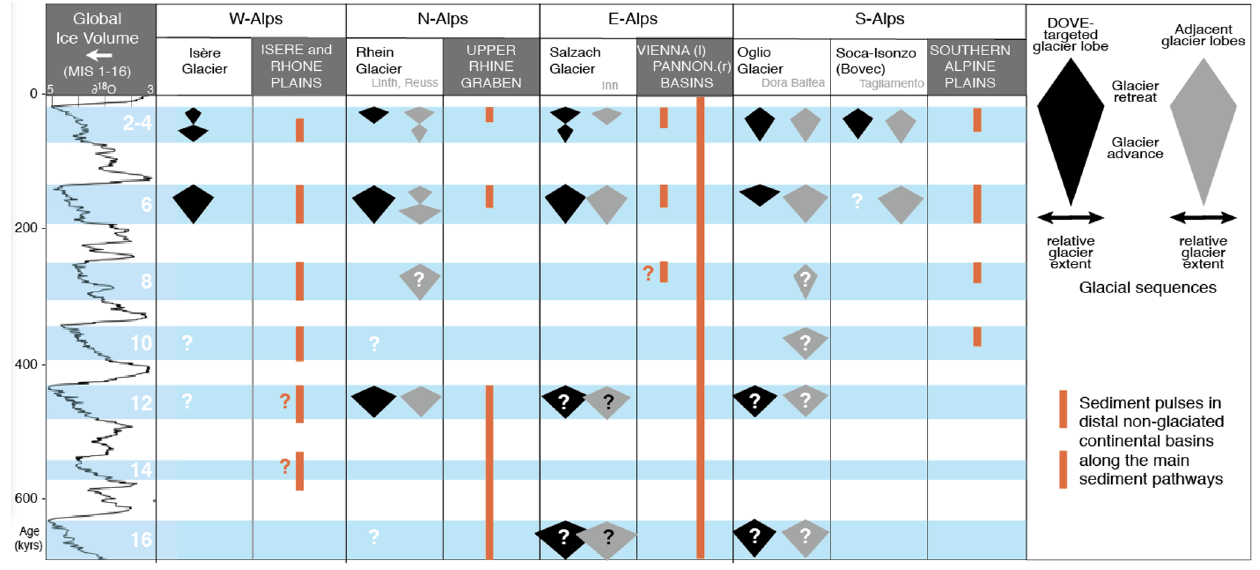
Figure 2. Present knowledge of the Quaternary glacial history of the Alps. Correlation of glaciation evidence with marine isotope record (Lisiecki and Raymo, 2005) is tentative; i.e., there is partly little confidence in presence and age as indicated by unfilled time spans and “?”. “Adjacent glacier lobes” indicate glacial catchments not directly targeted by DOVE but in the same Alpine domain that likely responded in a similar manner. Data for W-Alps: Mandier (1988), Nicoud et al. (2002), and Buoncristiani and Campy (2011); N-Alps: Preusser et al. (2011), Ellwanger et al. (2011), and Dehnert et al. (2012); E-Alps: Gabris and Nador (2007), van Husen and Reitner (2011), and Salcher et al. (2012); S-Alps: Bavec et al. (2004), Scardia et al. (2006), Pini et al. (2009), and Gianotti et al.